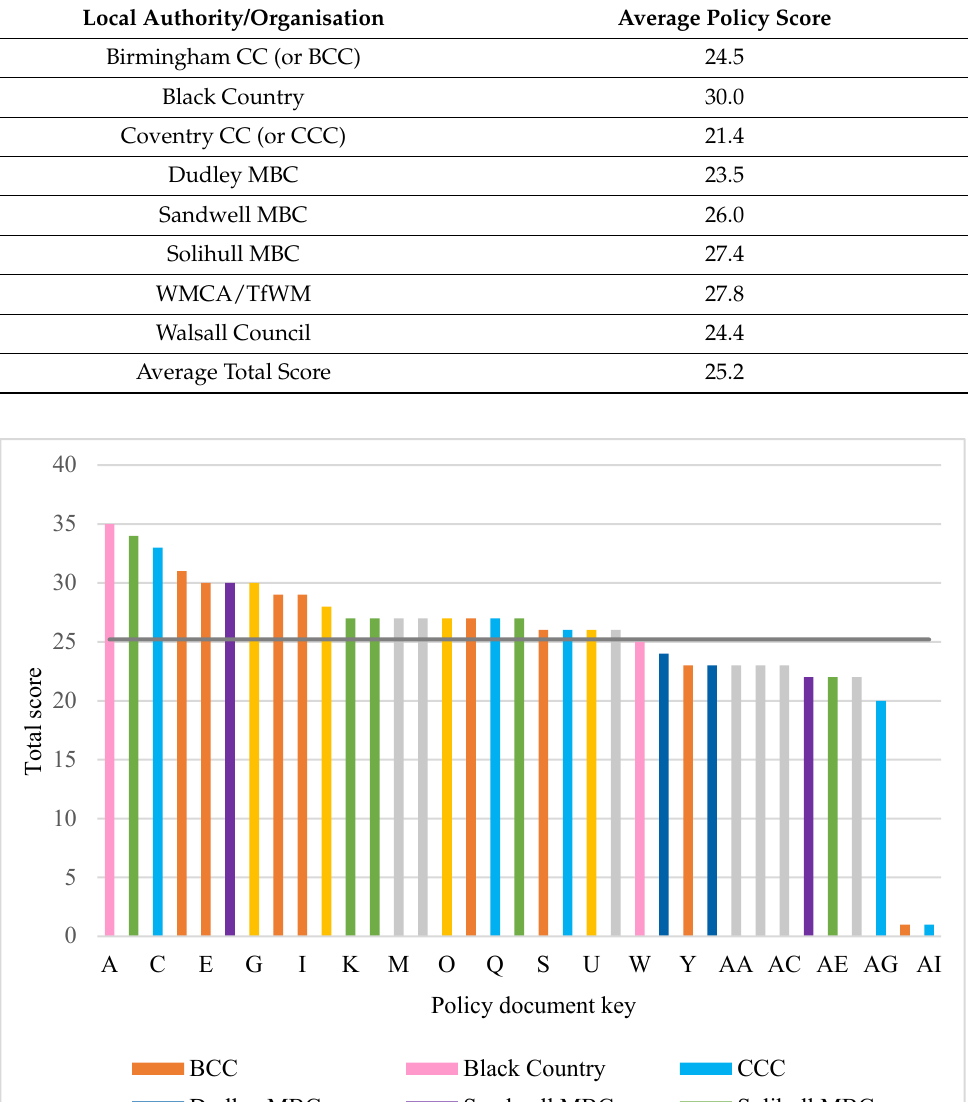
Table 5. Overview of results of the evaluation of policy documents by local authority or organisation.